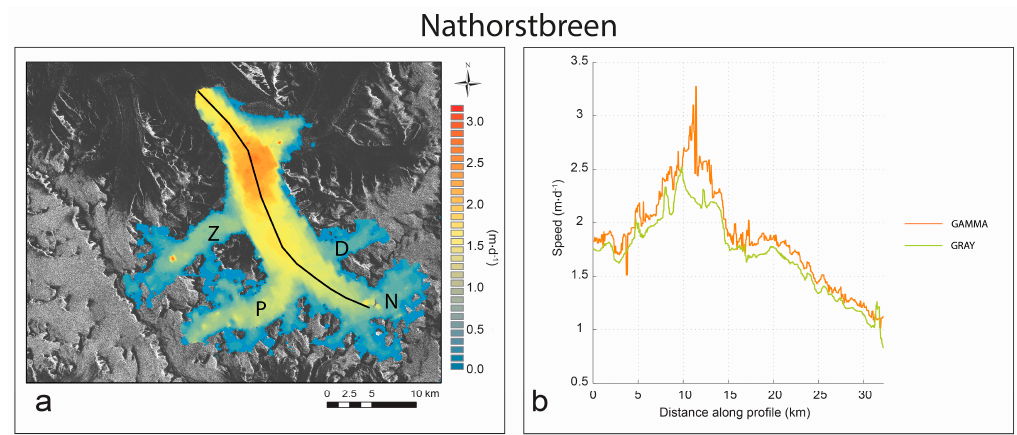
Figure 4. ( a ) Surface speed of the Nathorstbreen system (#20 in Figure 3) in S-Spitsbergen consisting of Nathorstbreen (N), Dobrowolskibreen (D), Polakbreen (P) and Zawatzkibreen (Z) (19 December 2012–12 January 2013; WF; GRAY); and ( b ) speed profile along the centerline of Nathorstbreen (orange: GAMMA; green: GRAY).